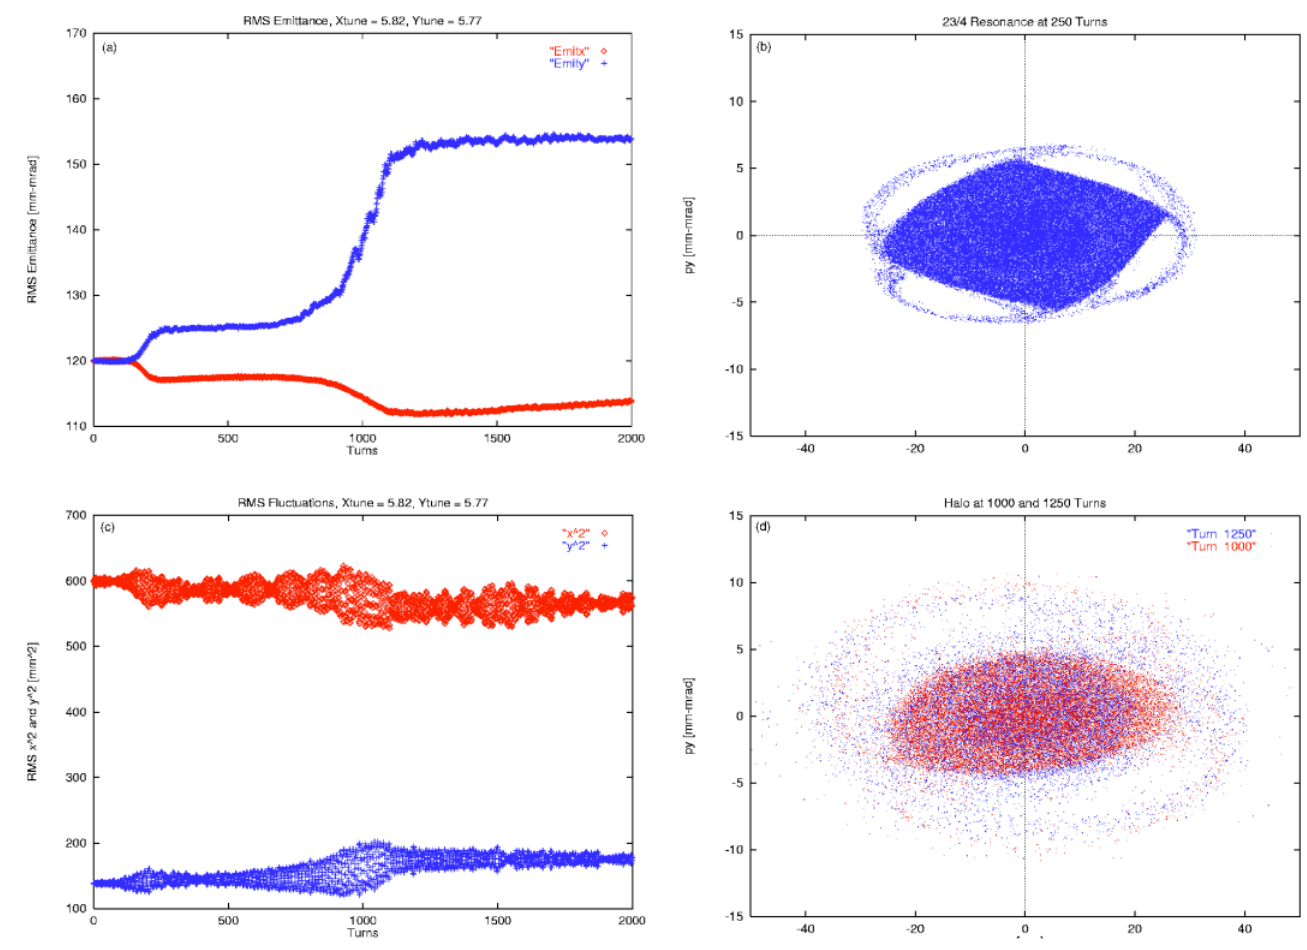
FIG. 16. (Color) Evolution of (a) rms emittances and (c) second moments (cid:6) D x 2 (cid:7) and (cid:6) D y 2 (cid:7) for n x (cid:1) 5.82 , n y (cid:1) 5.77 . Phase space plots in vertical plane for (b) 250 turns and (d) superposition of 1000 and 1250 turns.